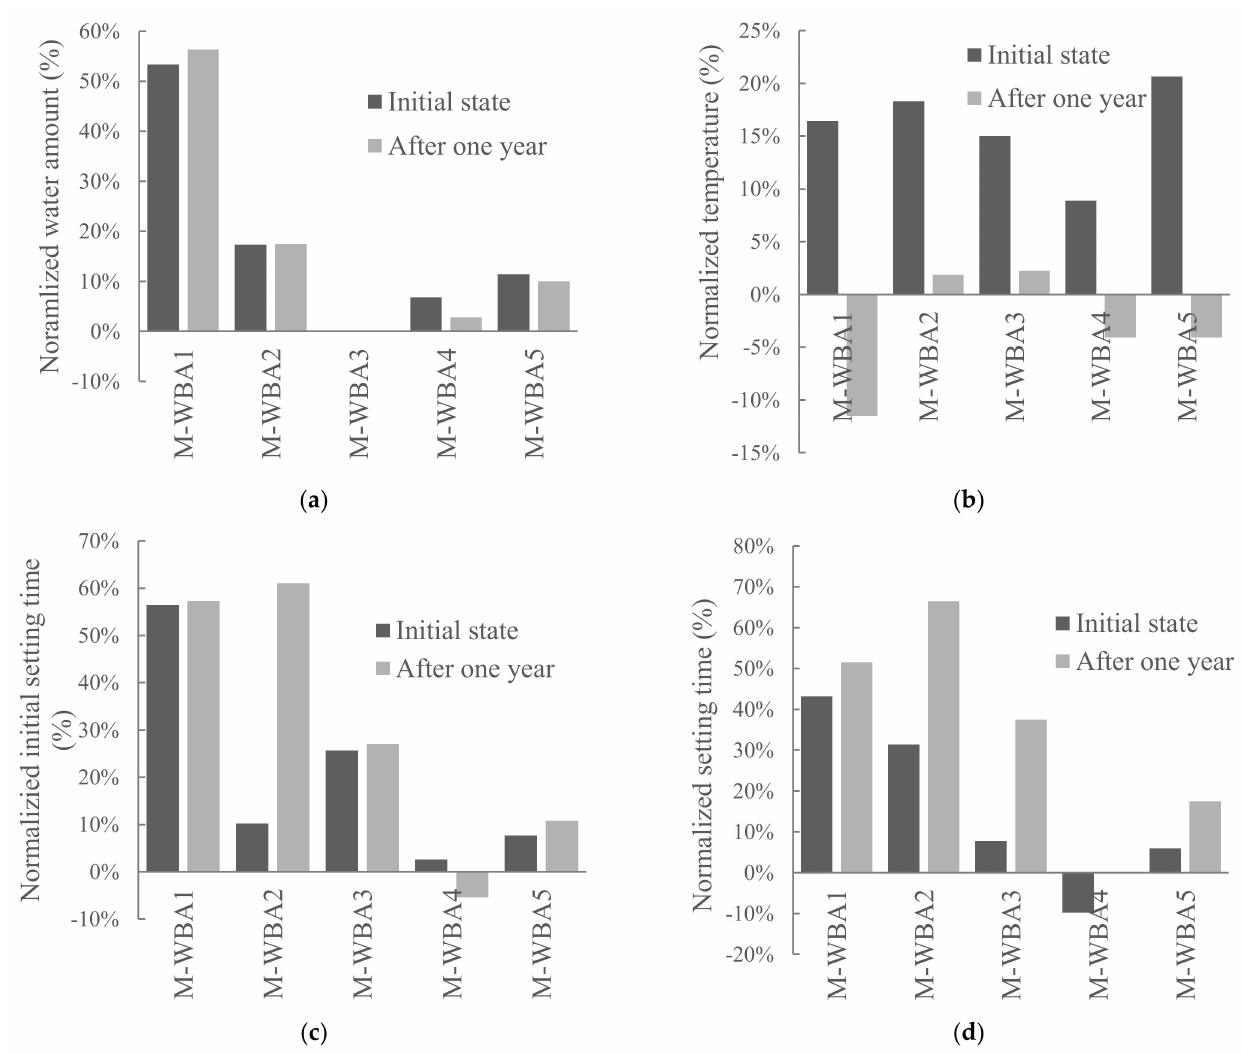
Figure 8. Properties of fresh paste as a function of the type and age of the WBA used as a 15% cement replacement: ( a ) Standard consistency; ( b ) Paste temperature; ( c ) Initial setting time; ( d ) Final setting time (Values are normalized to the reference mix; the data are available in Supplementary